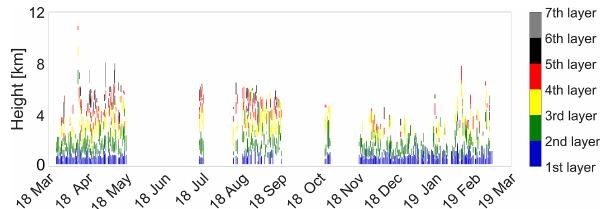
Figure 2. Night-time geometrical boundaries of the aerosol lay- ers observed between 6 March 2018 and 14 February 2019 at the measurement site in the UAE. The colour indicates the number of aerosol layers in the atmosphere. The gaps in the dataset seen from May to August and between September and November were due to instrumental